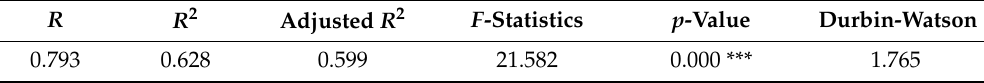
Table 9. Summary of Regression Model